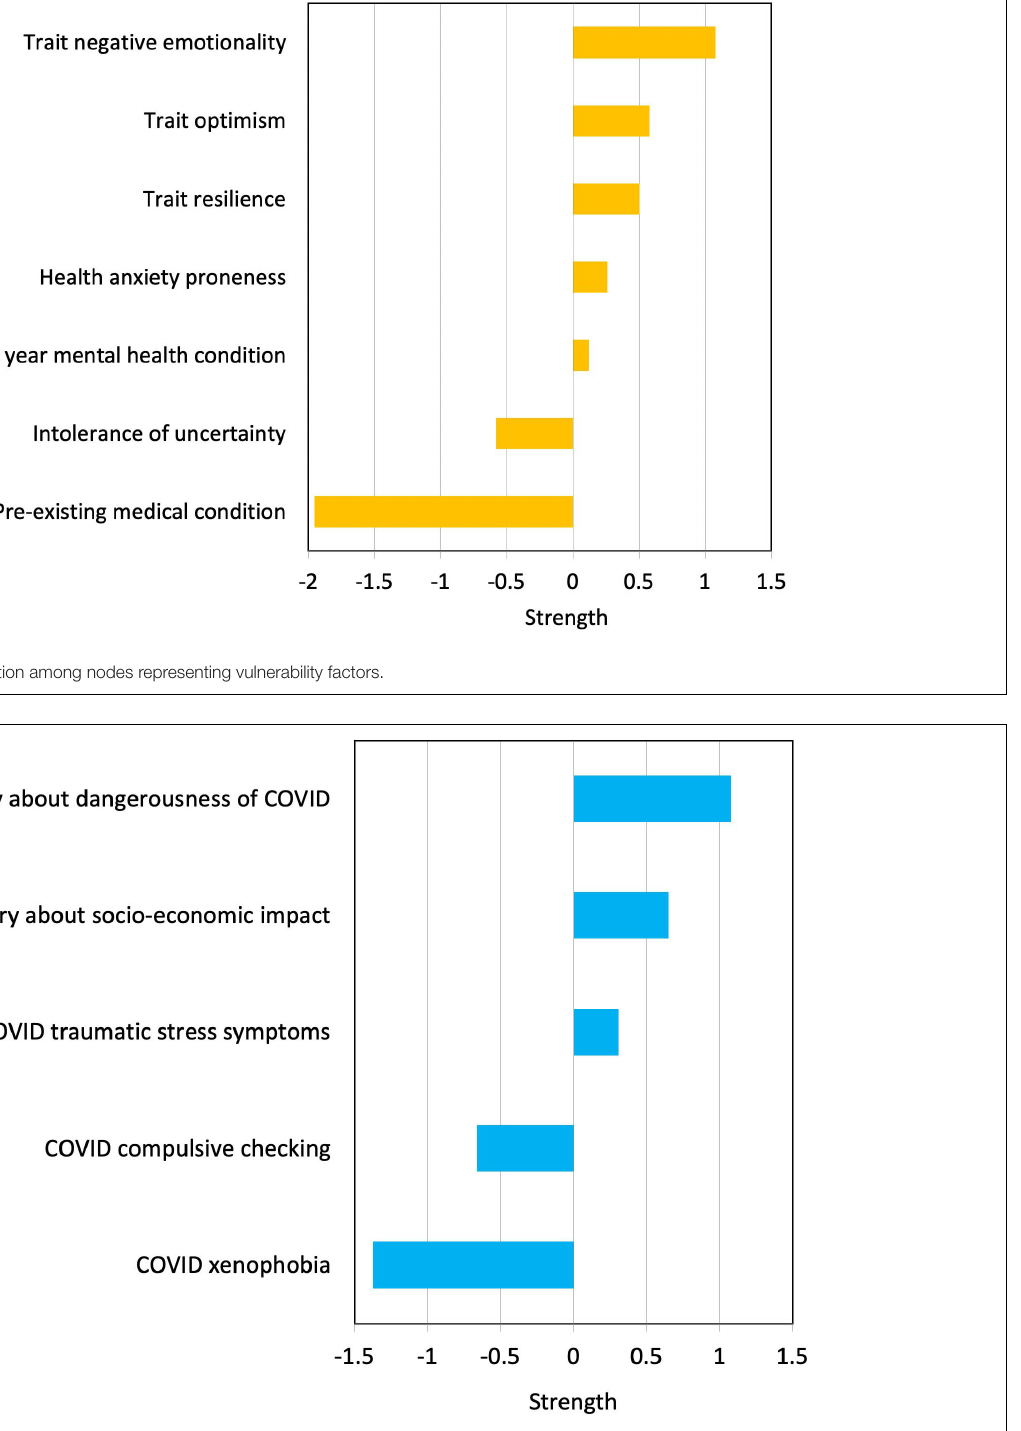
FIGURE 3 | Strength of connection among nodes of the COVID Stress Syndrome